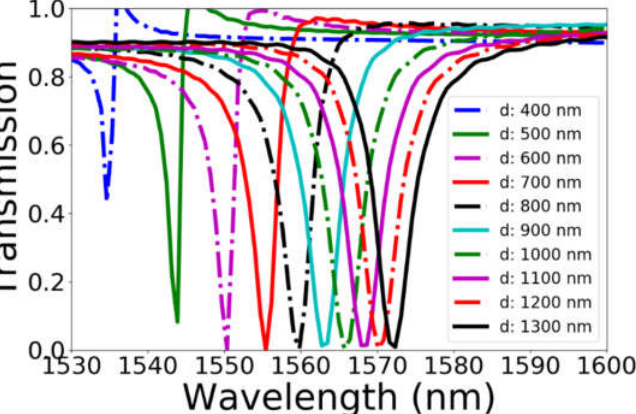
Figure 6. Transmission spectra of PhC-structure with hole-depth varied from 400 to 1300 nm. A redshift along with an increase in the linewidth of the resonant modes can be observed.